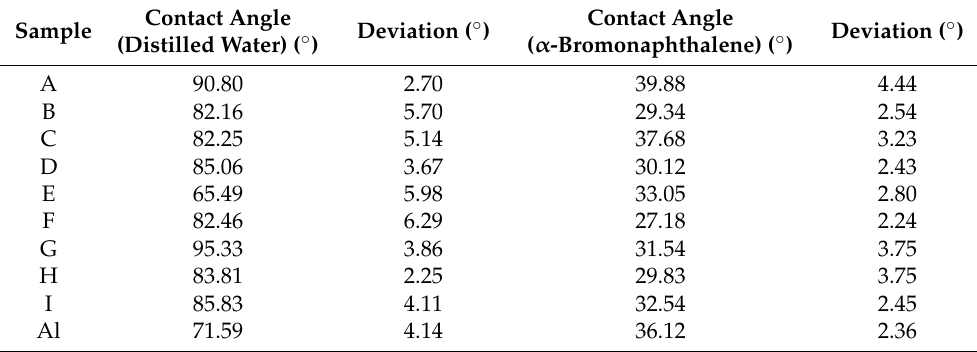
Table 6. Contact angles of oxide layers and aluminum alloy measured by distilled water and α -bromonaphthalene.